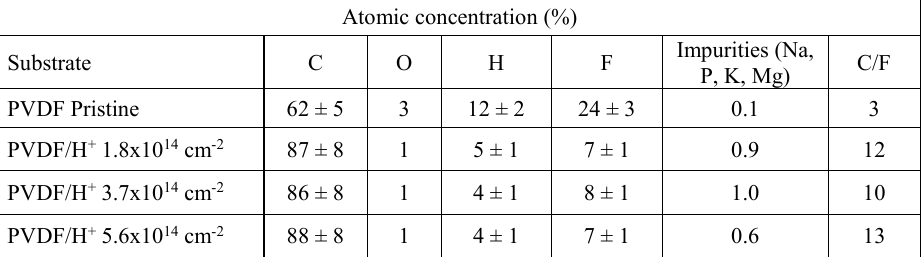
Table 4. The PVDF stoichiometry before and after the H-ion irradiation determined using RBS and ERDA